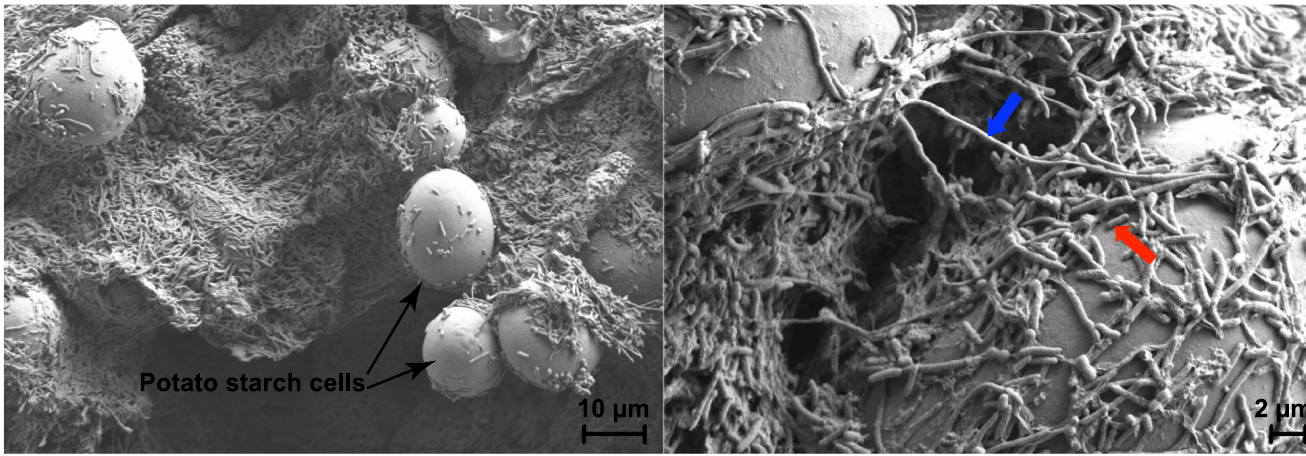
Fig 1. Filamentous cells and short cells of D . dadantii formed on potato tuber during later stage of infection at two magnifications. Potato tubers were inoculated with a clonal culture of D . dadantii . The observation was made at 48 hpi at the surface center position of the infected tuber. Black arrow: potato starch cells, blue arrow: a representative filamentous cell ( > 10 μ m), red arrow: a representative short cell ( < 10 μ m).